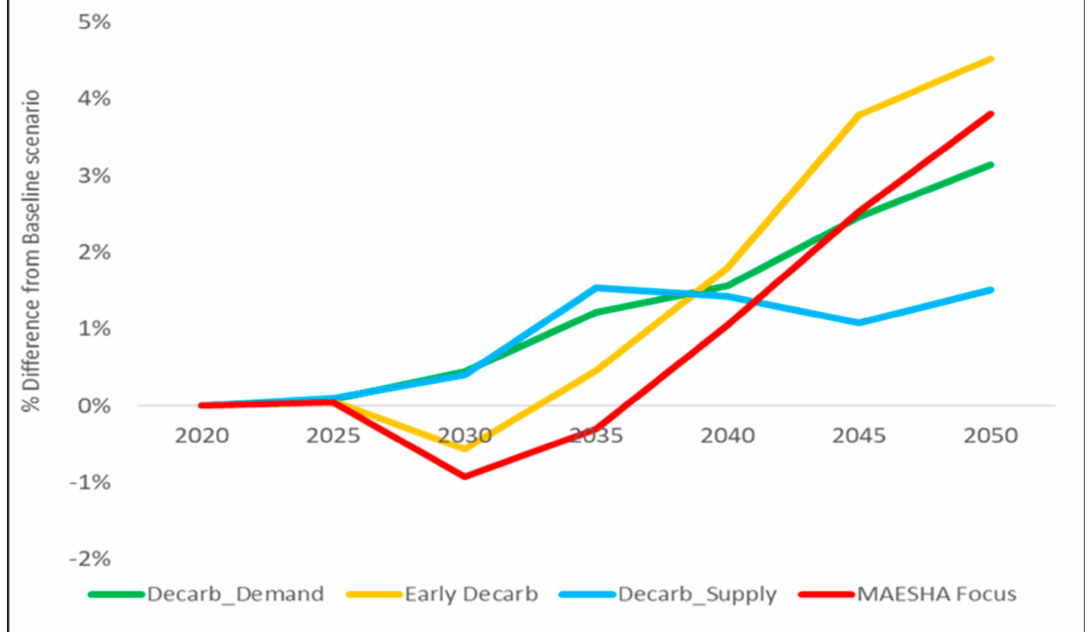
Figure 13. Impacts of decarbonization scenarios on Mayotte’s GDP in 2020–2050; source: